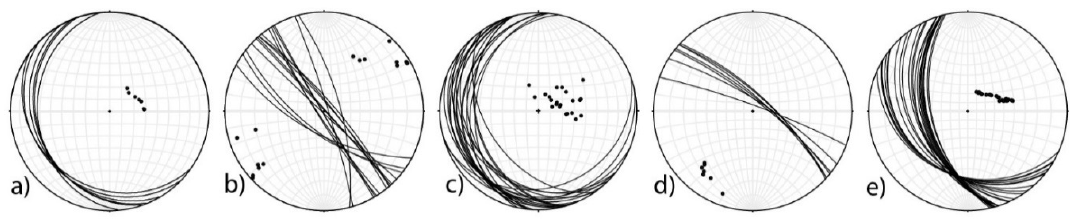
Figure 9. Lower hemisphere stereographic projections of bedding planes and poles of limb 0 ( a ), limb